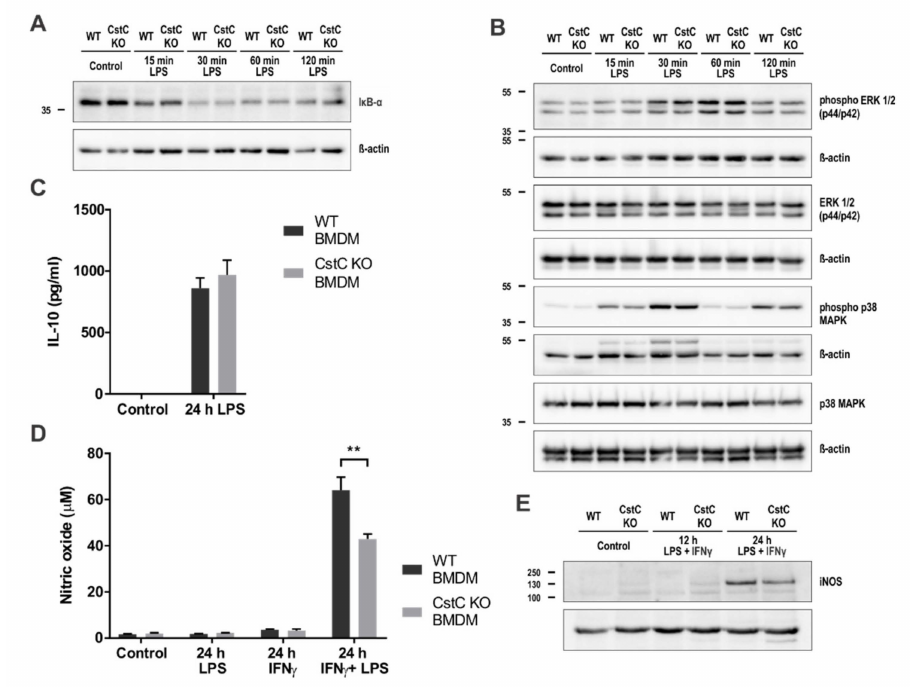
Figure 5. Cystatin C-deficiency in BMDMs upon LPS stimulation does not affect MAPK signaling pathways, anti-inflammatory IL-10 production or iNOS expression. ( A ) and ( B ) BMDMs were starved overnight and stimulated with LPS (100 ng/mL) for indicated times. Cell lysates were immunoblotted with indicated antibodies. ( C ) BMDMs were plated on 96-well plates and stimulated with LPS (100 ng/mL) for 24 h. Supernatants were collected and IL-10 release was measured with enzyme-linked immunosorbent assay (ELISA). ( D ) BMDMs were plated on 96-well plates and stimulated with LPS (100 ng/mL) or/and IFN γ (100 U/mL) for 24 h. Supernatants were collected and nitric oxide concentration measured with Griess reagent. ( E ) BMDMs were stimulated with LPS (100 ng/mL) and IFN γ (100 U/mL) for indicated times. Cell lysates were immunoblotted with indicated antibodies. Data shown are cropped blot images representative of three independent experiments. Data were obtained from three independent experiments performed in triplicate, and the results are presented as means ± S.D. ** p <